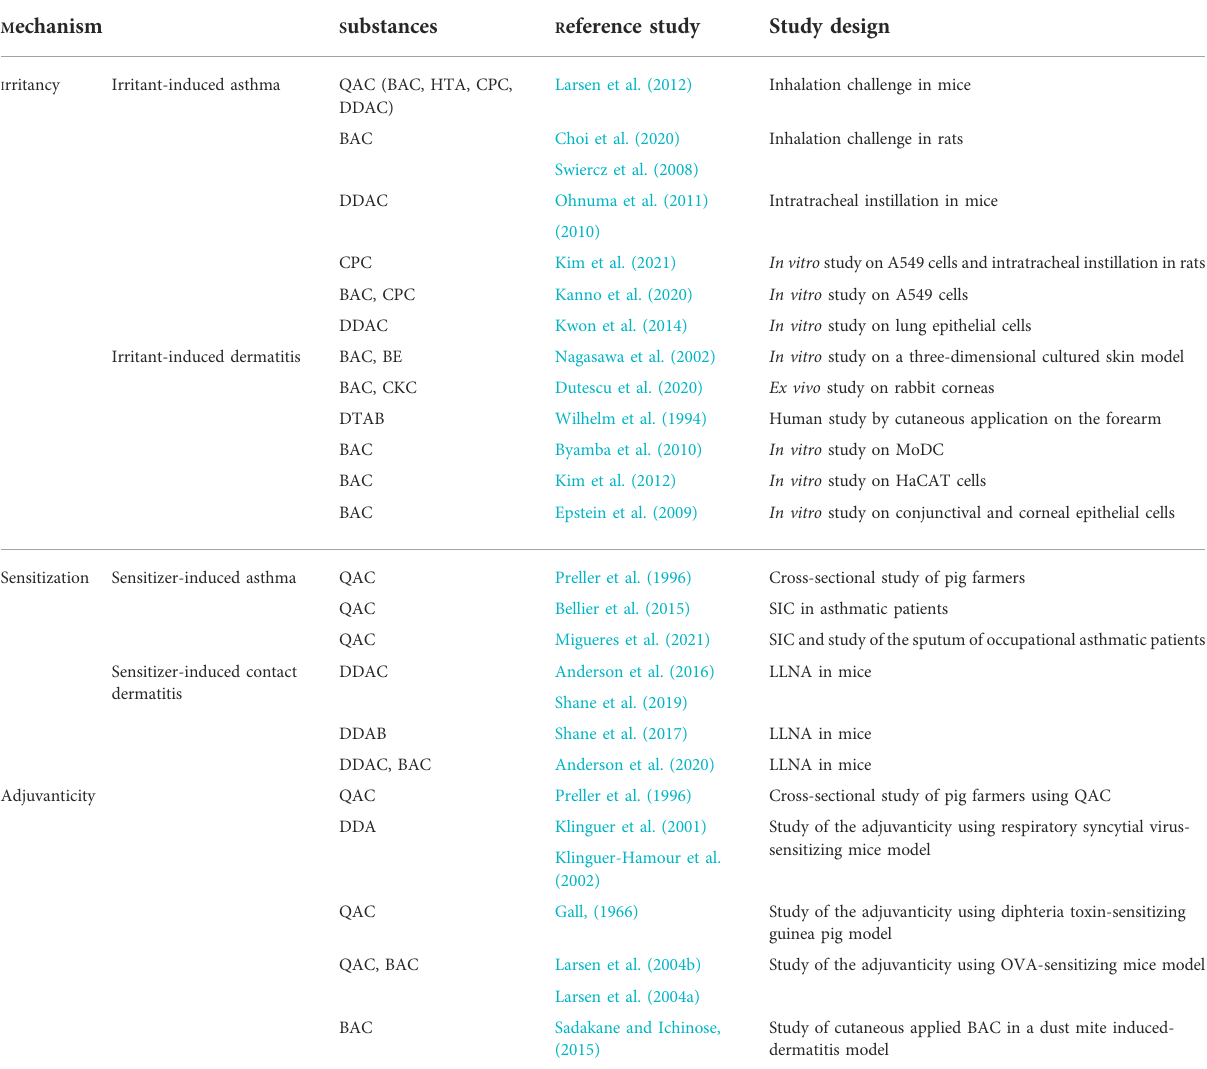
TABLE 2 Sum-up of the main studies about QAC immunotoxicological